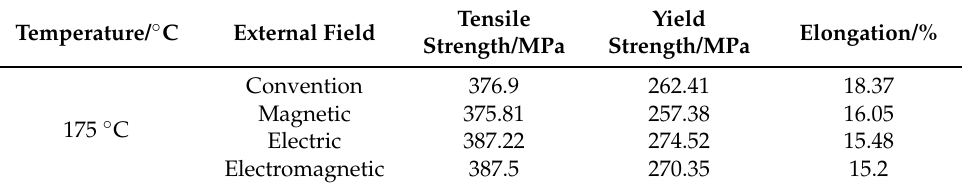
Table 2. Effect of different external fields on the mechanical properties of the alloy. Tensile Temperature/ ◦ C External Field